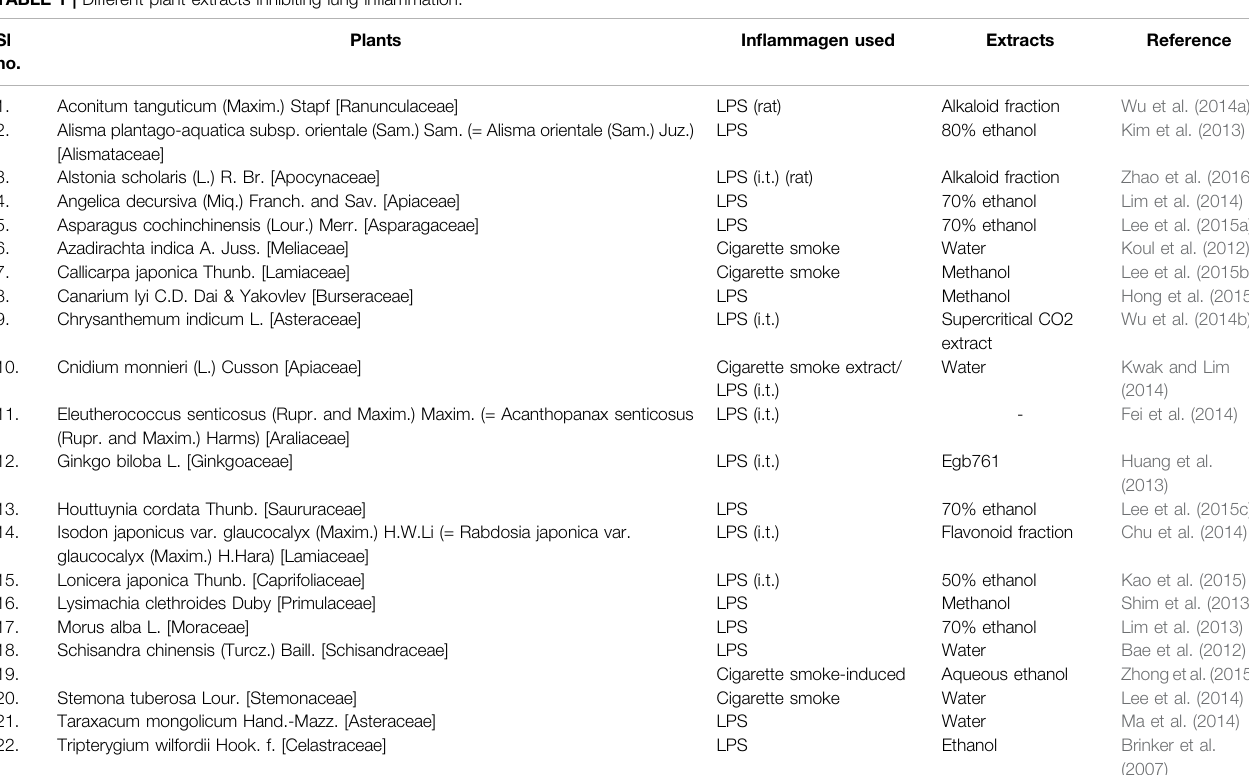
TABLE 1 | Different plant extracts inhibiting lung in fl